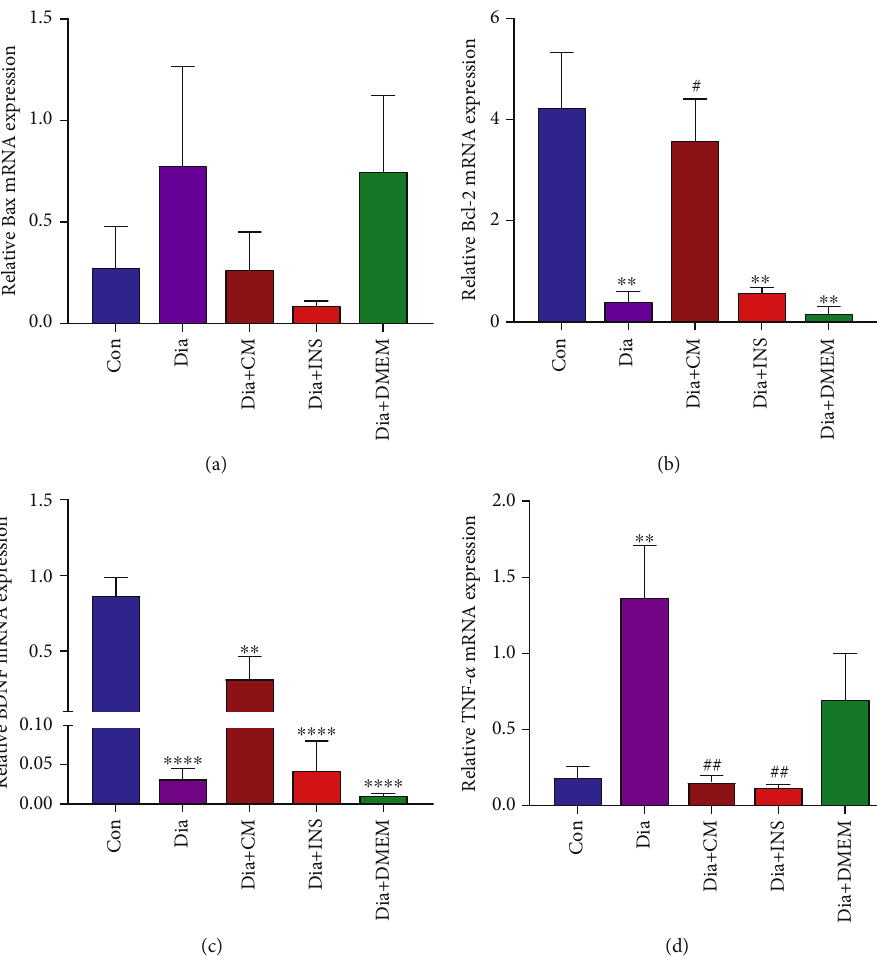
Figure 7: E ff ects of WJMSC-CM and insulin on Bax (a), Bcl-2 (b), BDNF (c), and TNF- α (d) gene expression levels in the hippocampus of diabetic rats. WJMSC-CM signi fi cantly increased and decreased hippocampal gene expression levels of Bcl-2 and TNF- α in diabetic rats, respectively. The values are presented as mean ± SEM ( n = 5 ). Signi fi cant di ff erences versus the control ( ∗∗ P < 0 : 01 , ∗∗∗∗ P < 0 : 0001 ) and diabetes rats ( # P < 0 : 05 , ## P < 0 : 01 ). Con: control; Dia: diabetes; Dia+ CM: WJMSC-CM-treated diabetic group; Dia +INS: insulin-treated diabetic group; Dia +DMEM: DMEM-treated diabetic